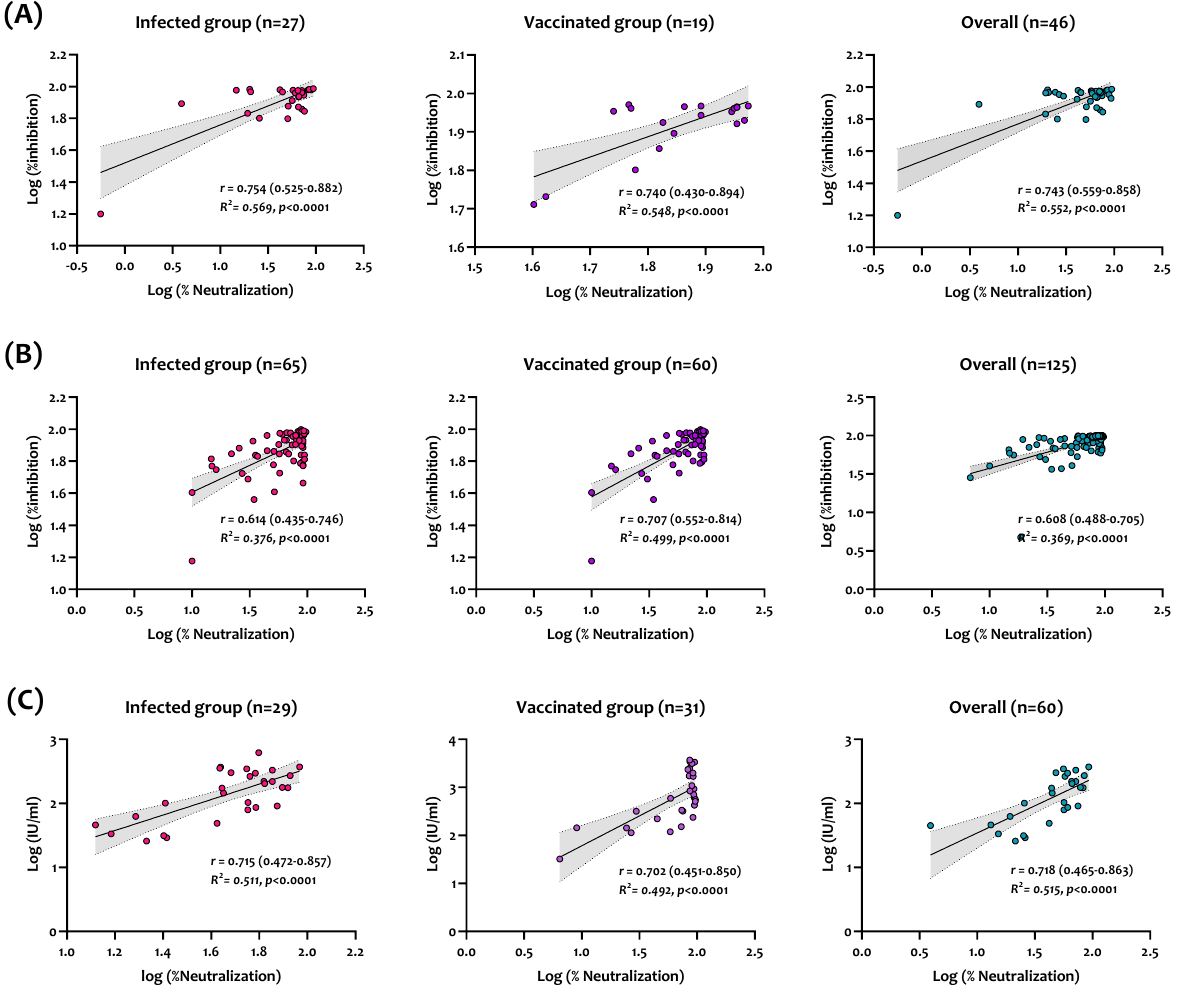
Figure 4. Correlation and linear regression analysis between pVNT and GenScript sVNT ( A ), Dynamiker sVNT ( B ), and Mindray NTAb sVNT ( C ) using samples collected from SARS-CoV-2 infected patients and vaccinated individuals. Correlation and linear regression analyses were performed in GraphPad Prism using Pearson’s correlation coefficients (r) and R 2 . Statistical significance was calculated using the two-tailed test. Presented data are the log-transformed values of neutralization (%) by pVNT and nAb results obtained by each sVNT. The dashed lines indicate the 95% confidence intervals of the linear regression